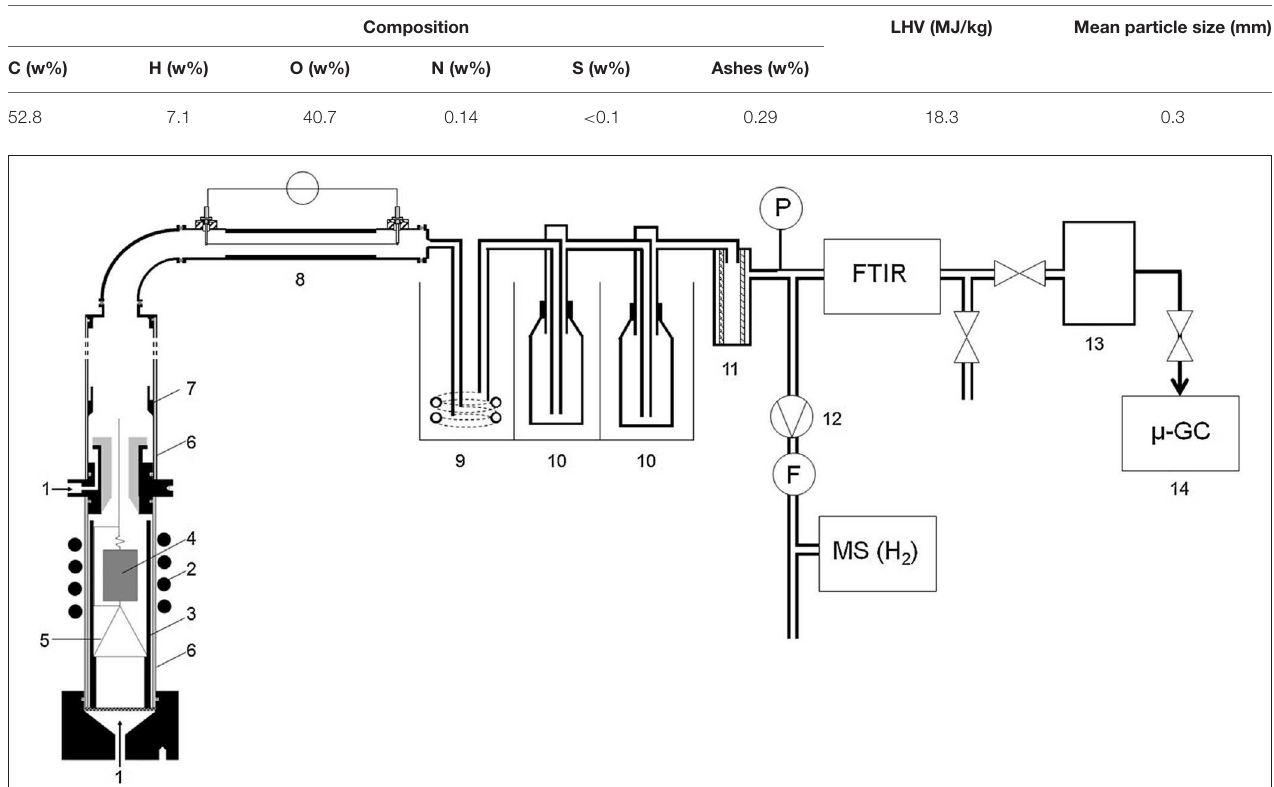
TABLE 1 | Ultimate composition and characteristics of the biomass used in the experiments. Composition